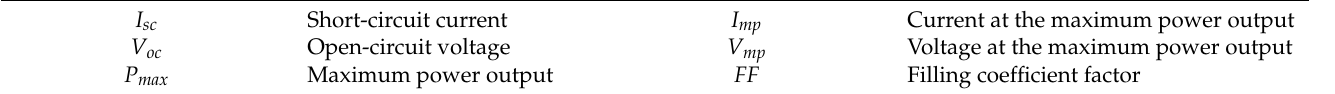
Table 1. Nomenclature for the electrical characteristics of the module. I sc Short-circuit current I mp Current at the maximum power output V oc Open-circuit voltage V mp Voltage at the maximum power output P max Maximum power output FF Filling coefficient